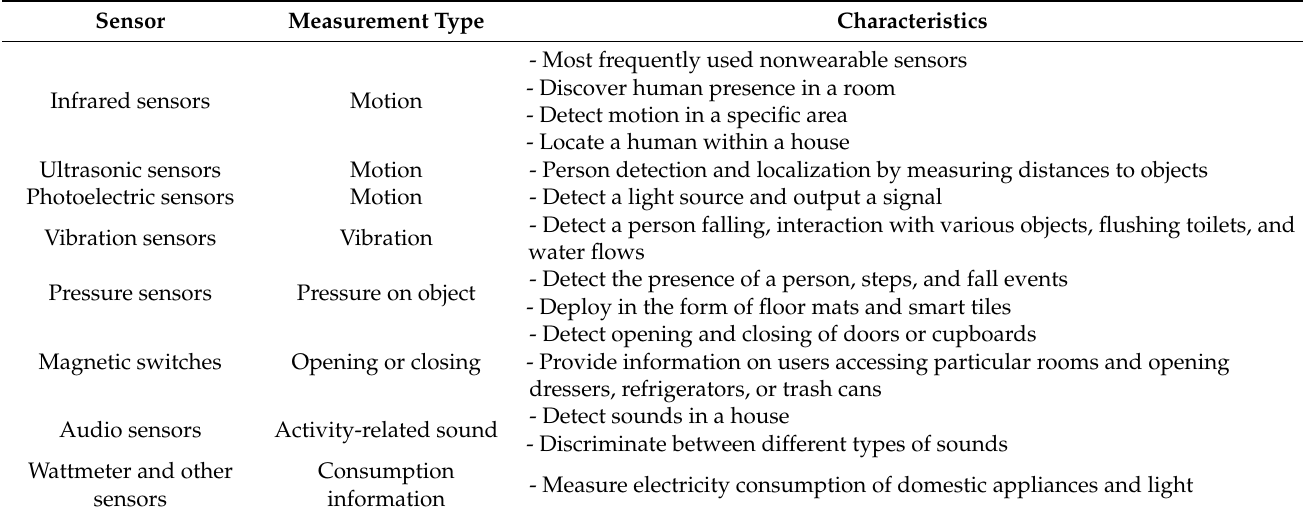
Table 2. Types and characteristics of nonwearable